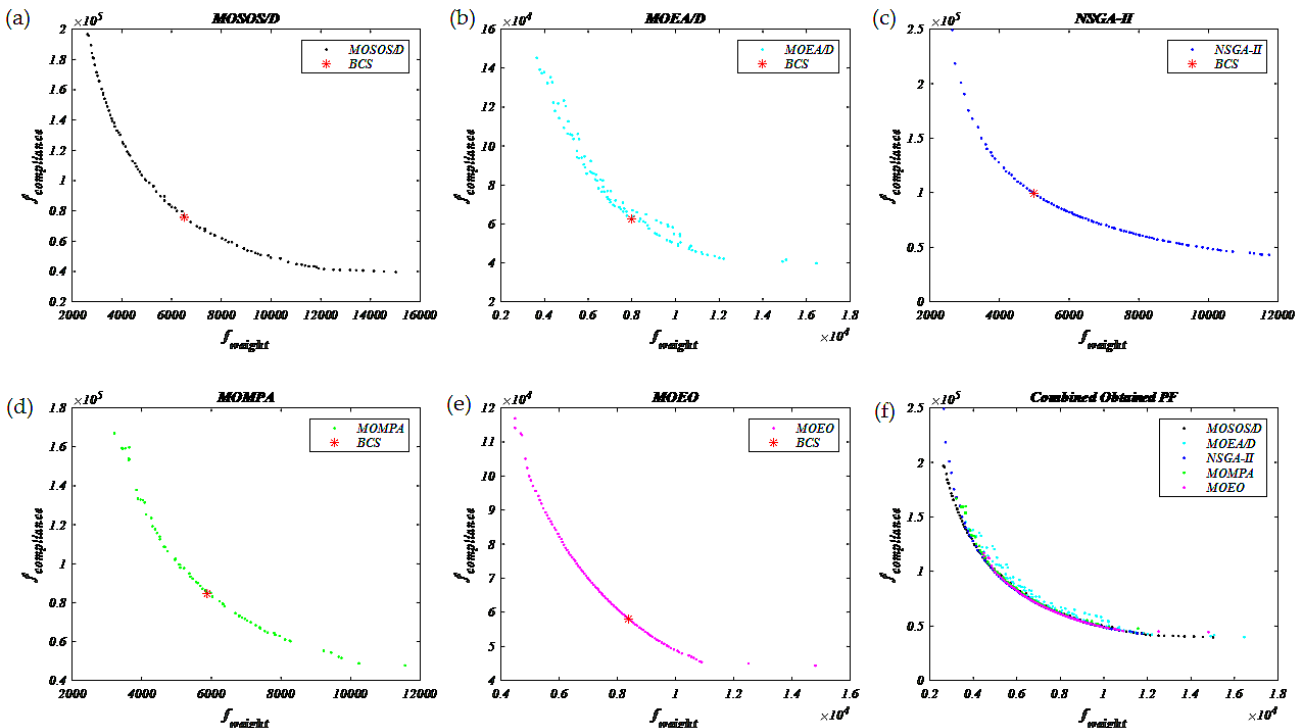
Figure 17. The best Pareto fronts for the 10-bar truss of the considered algorithms namely ( a ) MO-